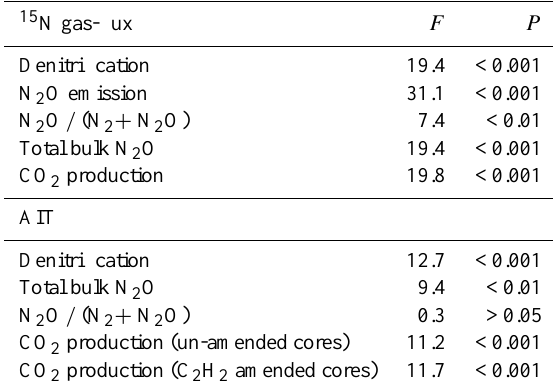
Table 3. Comparison of mean flux rates and ratios between land use types for the two field methods using one-way ANOVA. All variables are log-transformed. F : F statistic; P : probability